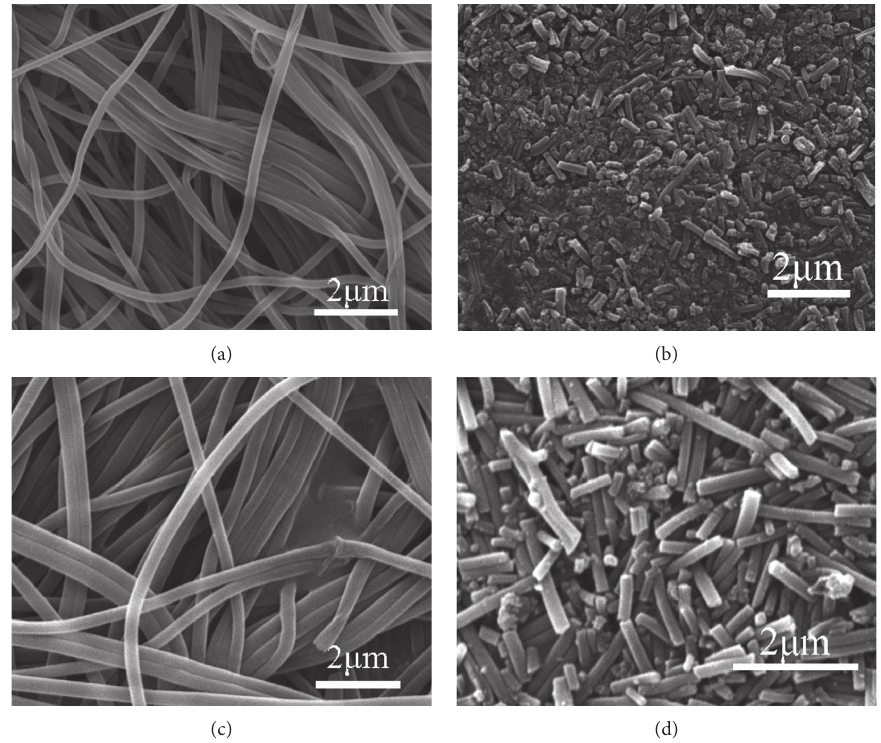
Figure 5: SEM patterns of TiO 2 precursor (a), TiO 2 nanofibers (b), 5% WO 3 /TiO 2 precursor (c), and 5% WO 3 /TiO 2 nanofibers